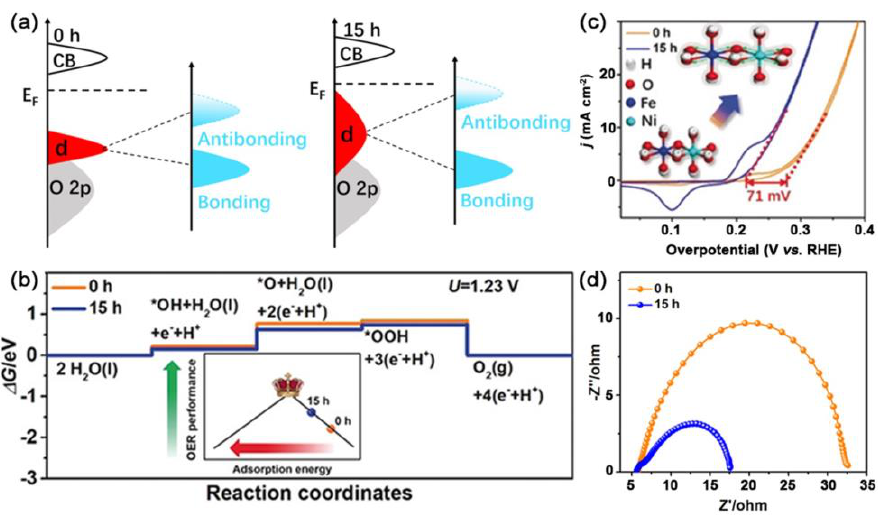
Figure 4. ( a ) Schematic illustration of the band structure of NiFe − LDH. ( b ) The calculated Gibbs free energy of OER for NiFe − LDH. ( c ) CV curves after i R and BET − correction. ( d ) Nyquist plots of NiFe − LDH. Reproduced with permission from ref. [99]. Copyright 2019, Wiley-VCH.